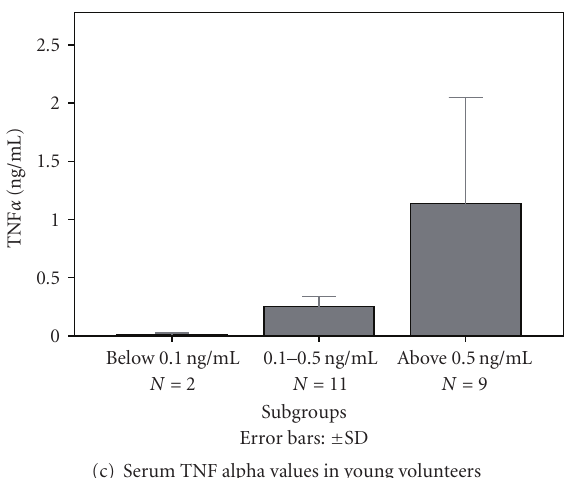
Figure 3: Serum TNF α individual values in young volunteers (a) order of individual values (b) demonstrate three subgroups of the young population